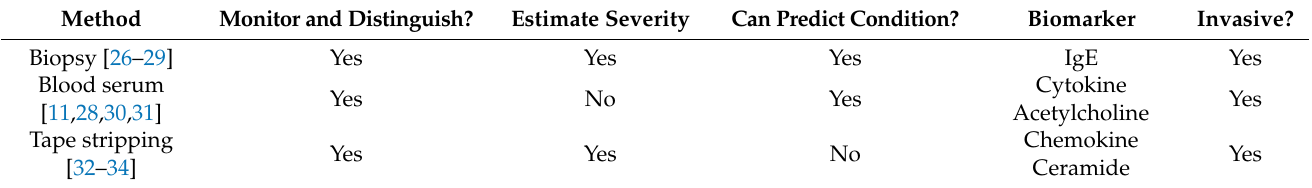
Table 1. Empirical medical tests for diagnosing and monitoring the severity of AD in vitro. None of the methods can be applied in a remote (non-laboratory) location, and all require a specialist operator.